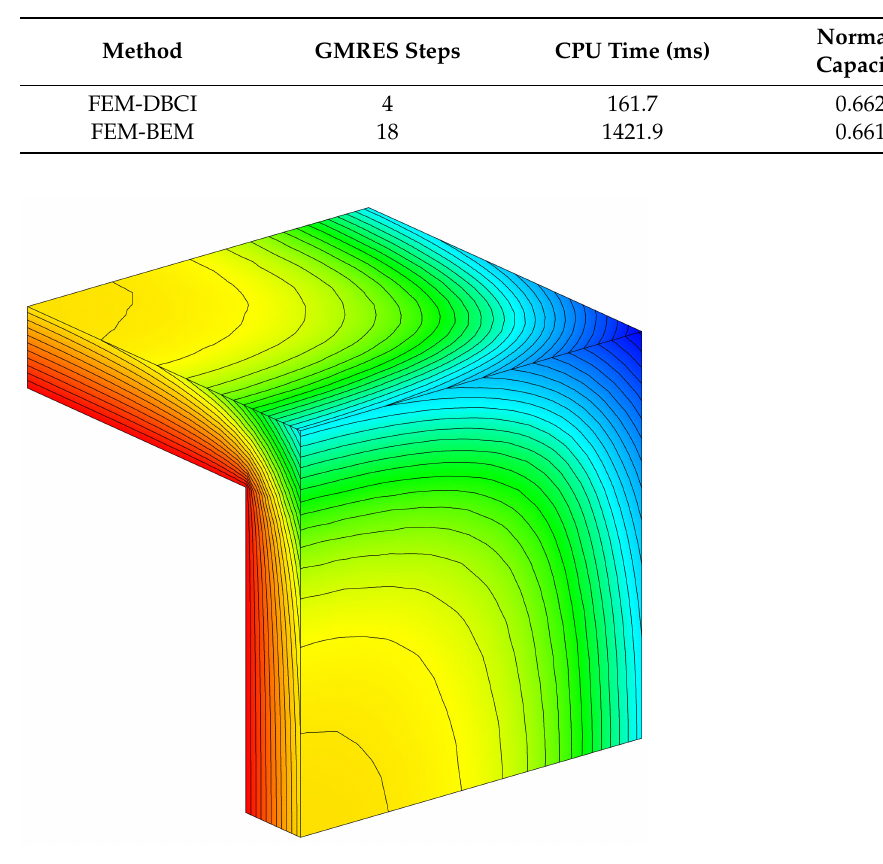
Figure 6. Contours of the potential around the cube conductor.